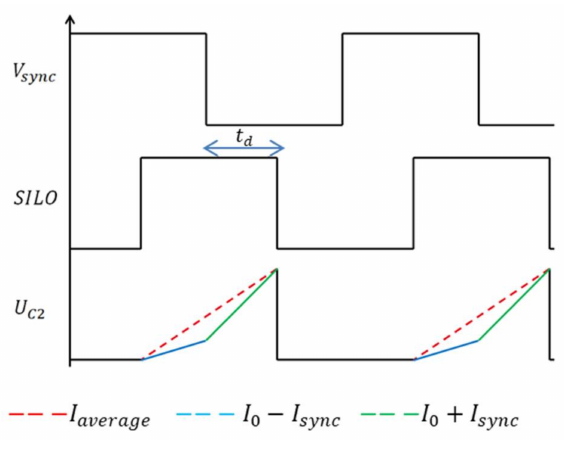
Figure 5. Locking